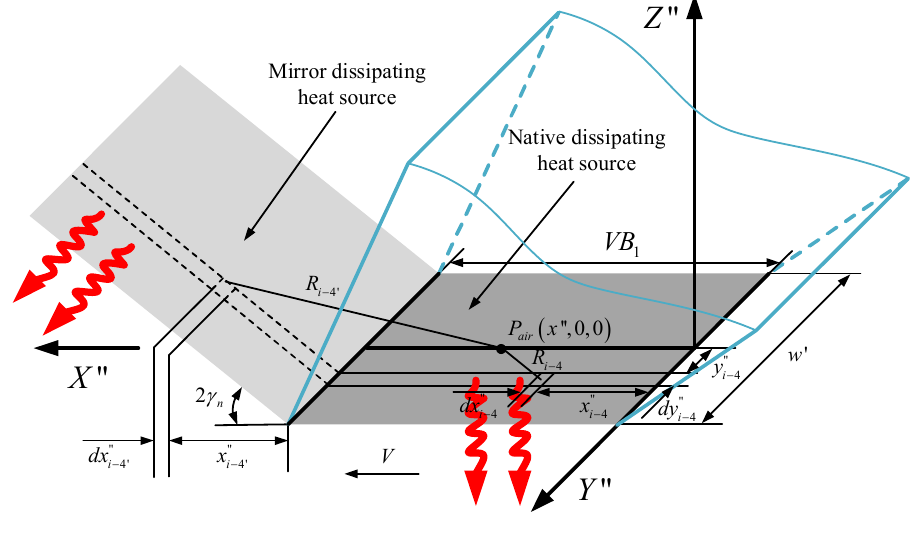
Figure9. Dissipating heat source. Figure 9. Dissipating heat